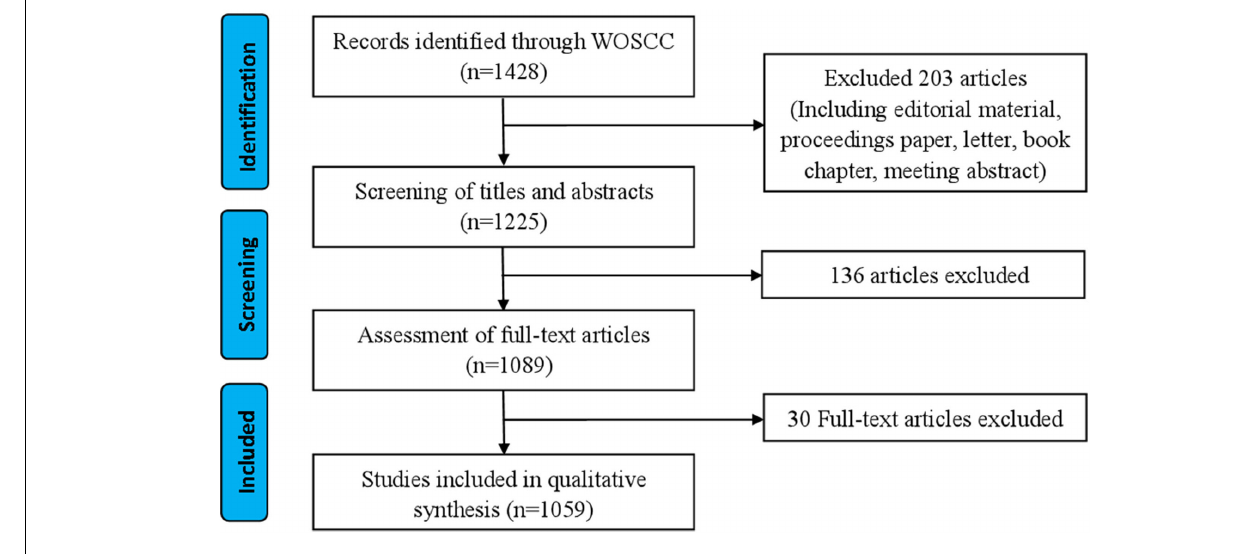
FIGURE 1 | Study flow diagram.